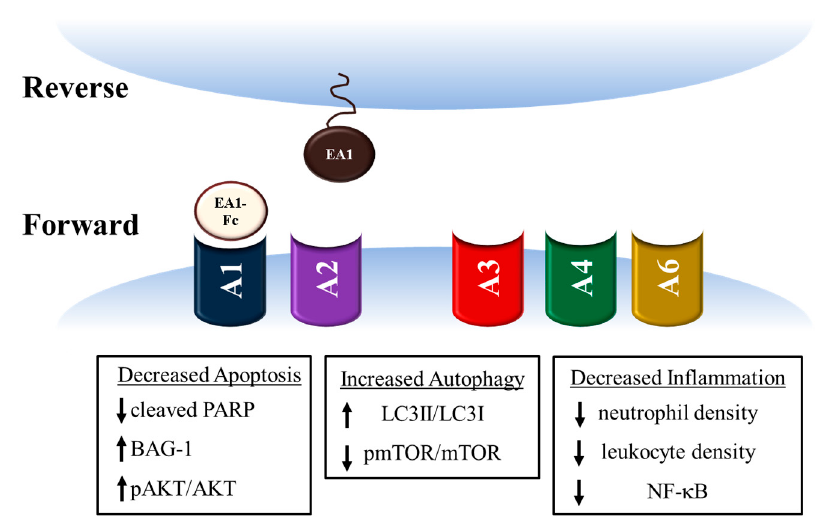
Figure 2. Potential Mechanisms of EA1-Fc Mediated Cardioprotection. Treatment with Ephrin A1-Fc (EA1-Fc) in a mouse model of myocardial infarction (MI) was shown to alter expression of five Ephrin receptors (EphA1-A4 and EphA6) as well as endogenous EA1 ligand when compared to the vehicle treated MI group. Canonical ephrin signaling regulates a wide-variety of physiological processes. The cardioprotective role of EA1-Fc may be attributed to ephrin signaling. In support of this, in the EA1-Fc MI group, indicators of decreased apoptosis, increased autophagy, and decreased inflammation were observed. The possibility also exists that EA1-Fc injection is cardioprotective through a mechanism that is not normally attributed to ephrin signaling.